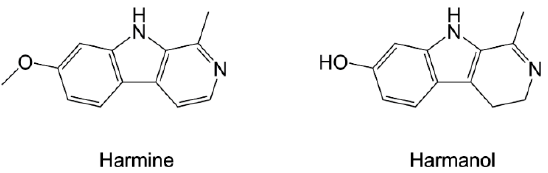
Figure 8. Chemical structures of harmine and harmanol [81,106].